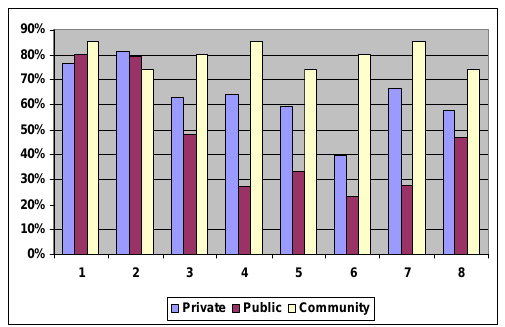
Graph 1: Importance given to different intelligences in all Graph 2: Comparison between primary and secondary the three sectors sections in all three sectors (where 1=verbal, 2=logical, 3=spatial, 4=kinesthectical, 5=musical, 6=interpersonal, 7=intrapersonal,